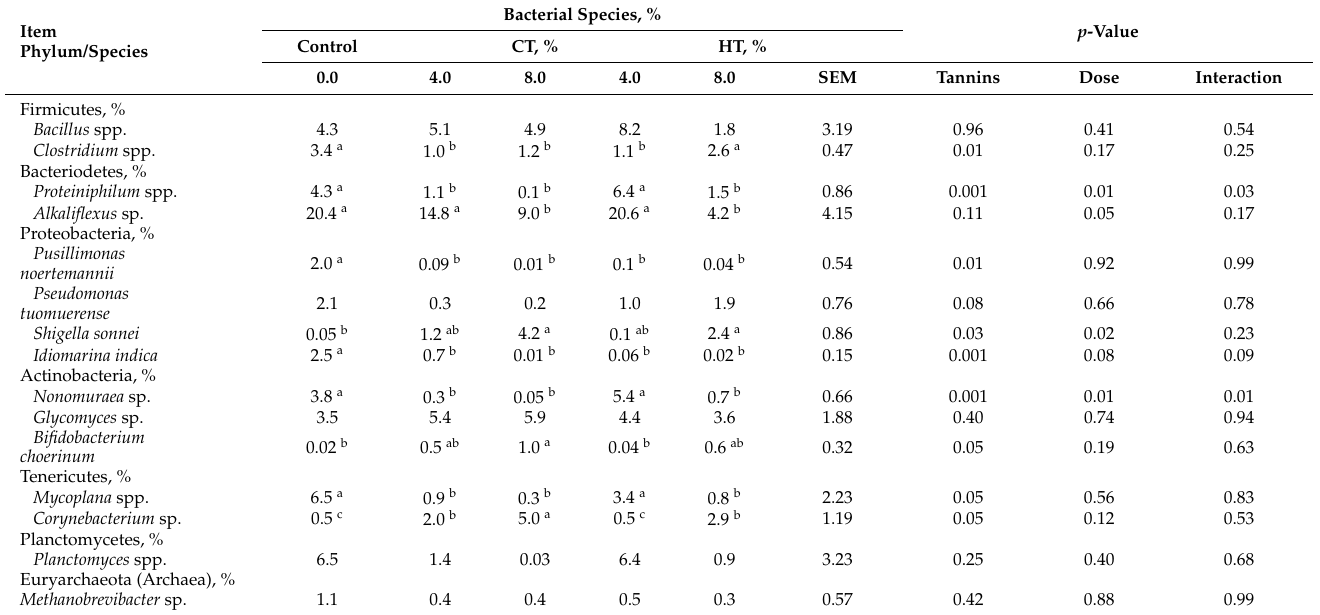
Table 3. Mean relative abundance values (%) of the most predominant bacterial species (>1.0%) as a function of the addition of tannins with different dose levels of tannins in dairy cattle